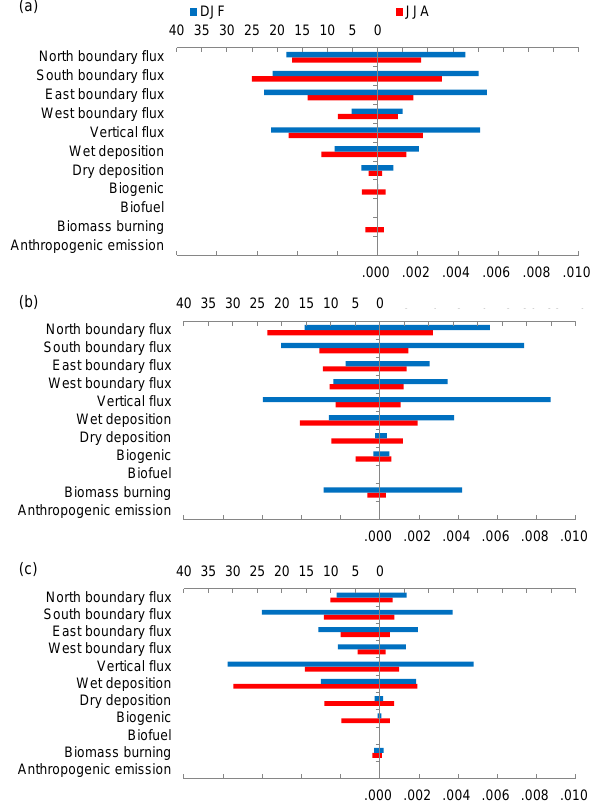
Figure 14. The MAD (TgCseason − 1 , right) and relative contri- bution (%, left) of each organic carbon process (flux) in (a) NC, (b) SC, and (c) SCB obtained from simulation ANNmet. Blue lines are for DJF and red lines are for JJA. Transport fluxes were calcu- lated at the boundaries while other sources and sinks were calcu- lated as the sums over the grid cells of the region under